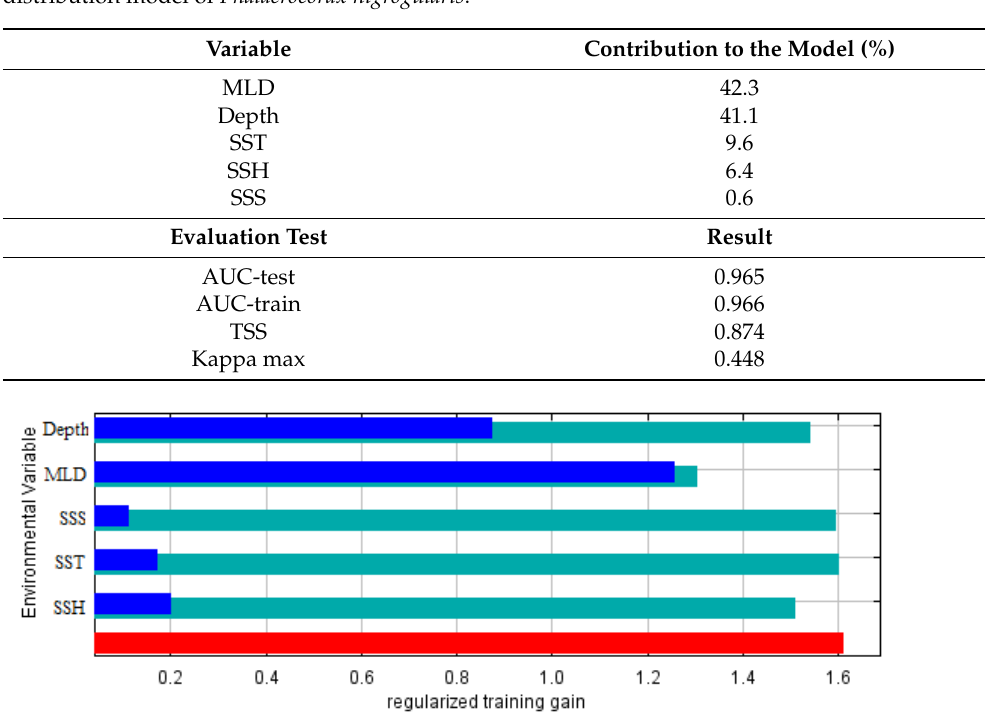
Figure 2. Jackknife evaluation of the relative importance of each variable. Depth: sea floor depth, MLD: mixed layer thickness, SSS (sea surface salinity), SST (sea surface temperature), SSH (sea surface height).